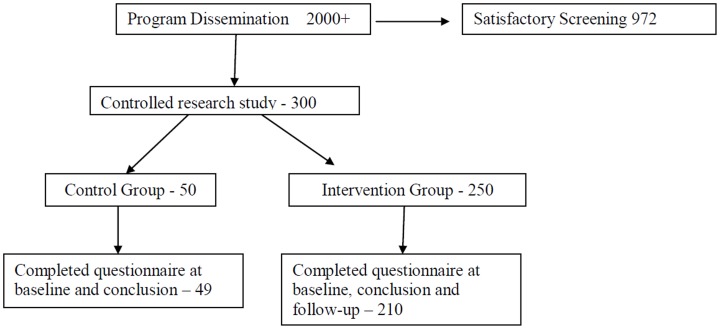
Participation flow.